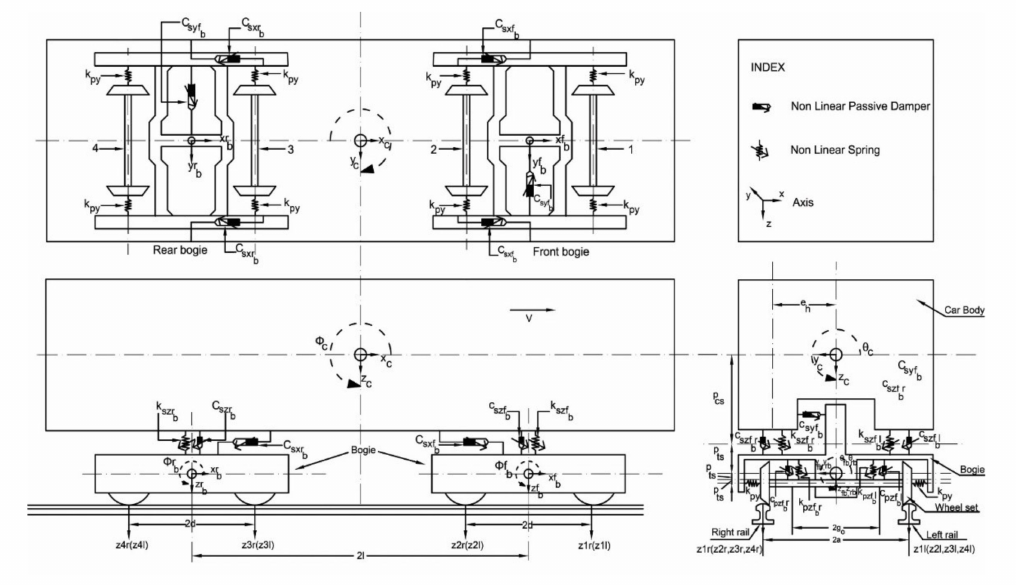
Figure 5. Structure of the Linke Hofmann Busch (LHB) rail vehicle